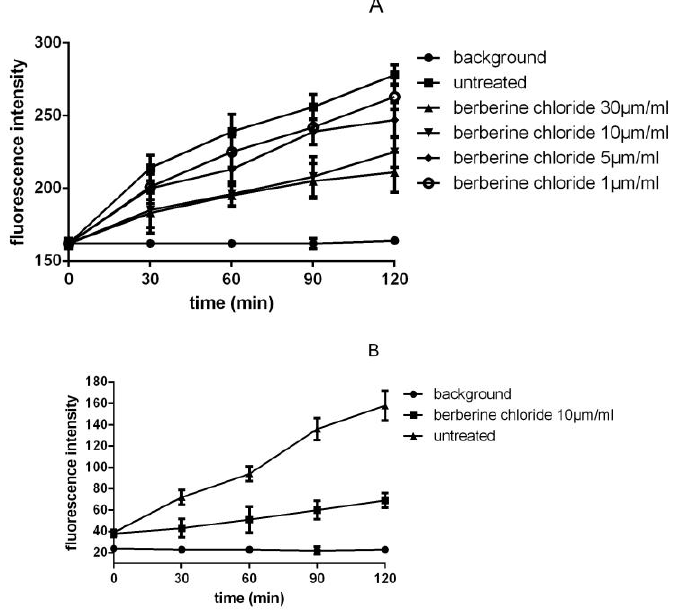
Figure 4. Fluorescence spectrophotometry detection of SrtA activity. ( A ) Fluorescence spectrophotometery detection of SrtA interaction with LPXTG-EGFP in time. ( B ) Fluorescence spectrophotometry detection of SrtA interaction with Dabcyl-QALPXTGEE-Edans in time.